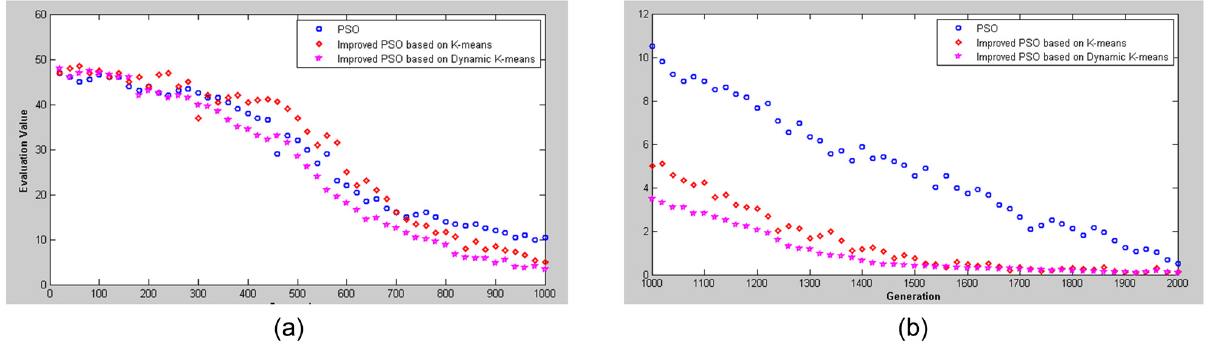
Figure 4: Performance comparison: ( a ) performance before 1,000 generations; ( b ) performance from 1,000 to 2,000